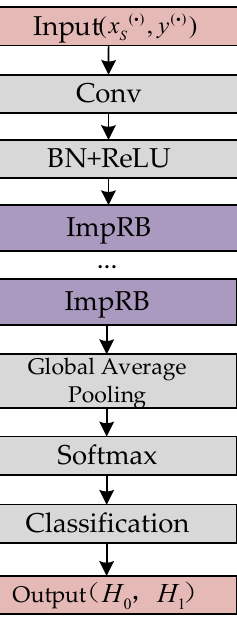
Figure 4. ImpResNet structure in the spectrum sensing model. The signal samples pass through one-dimensional convolution first, and then enter the ImpRB. Multiple improved residual blocks are superimposed to enhance the ability of feature extraction. After residual learning, the fully connected layer (FC) is replaced by global average pooling (GAP) [29]. GAP was chosen because it takes the average of each feature map which can integrate global spatial information. Compared with FC, GAP does not require a large number of training parameters, thereby reducing the risk of over-fitting. The output dimensions of the GAP are equal to the number of categories, and thus the resulting vector can be fed directly into the Softmax layer, which maps the outputs of multiple neurons into the interval of (0,1) to realize the classification of